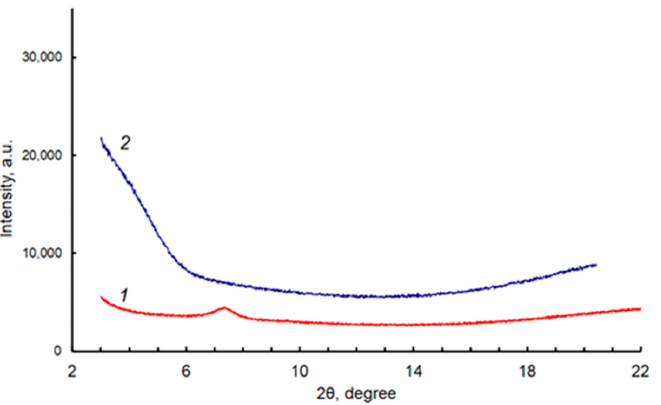
Figure 5. XRD patterns for the RTE ‐ deposited layers of Cu ‐ PP ‐ IX (1, red line) and Cu ‐ C ‐ e6 (2, blue line).